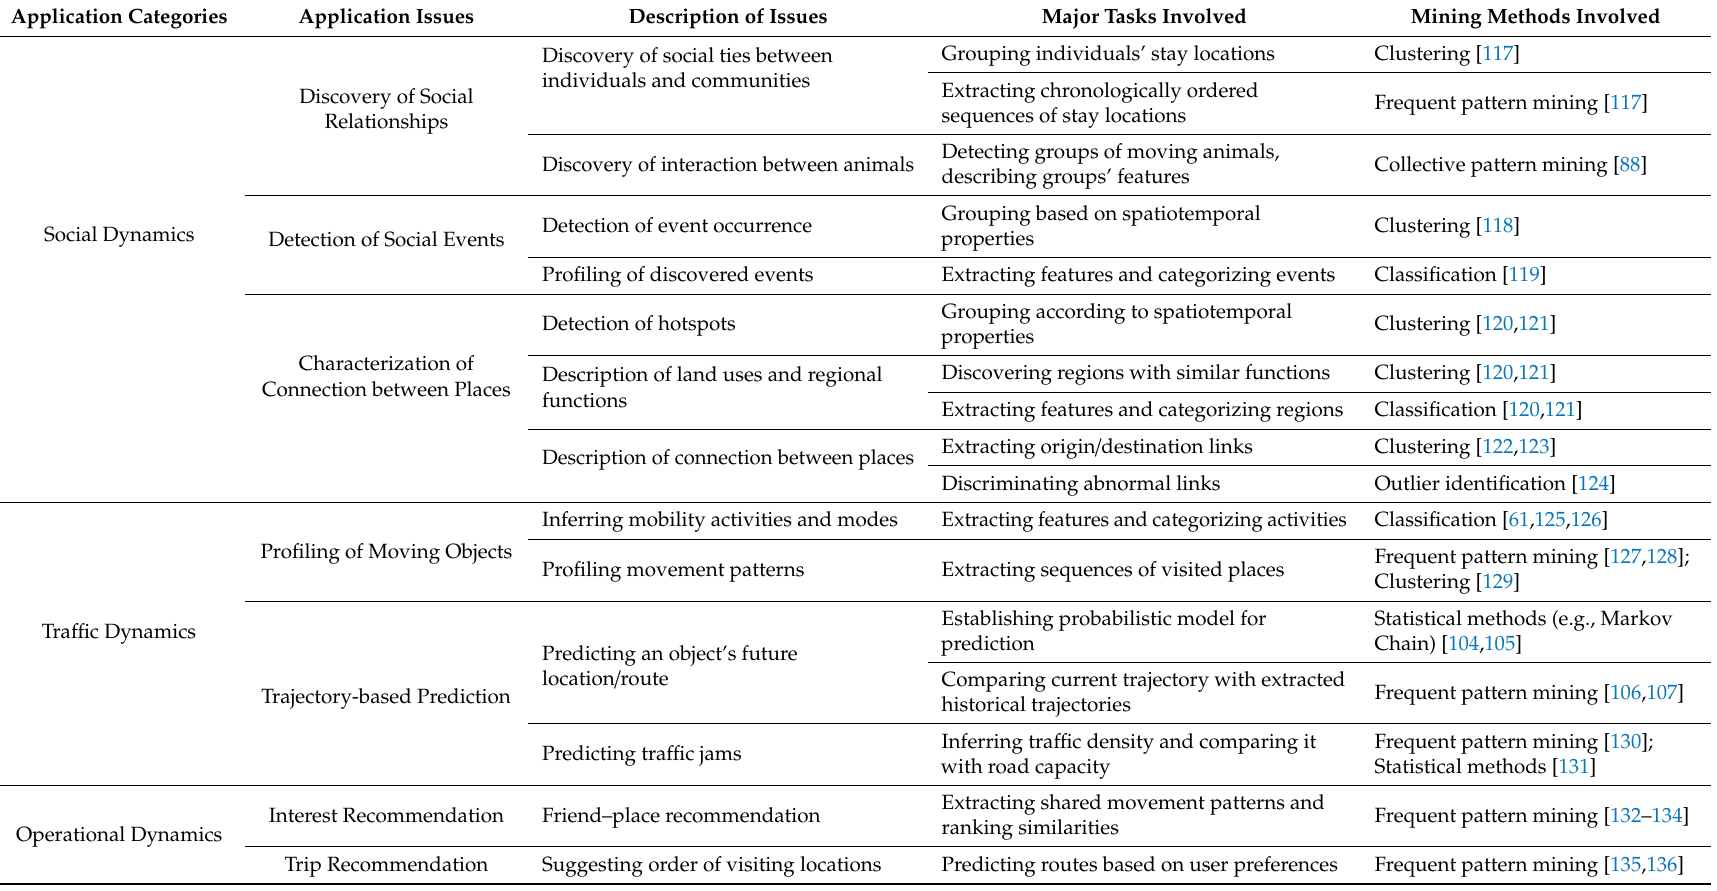
Table 2. Relationships between trajectory-related application issues and trajectory mining